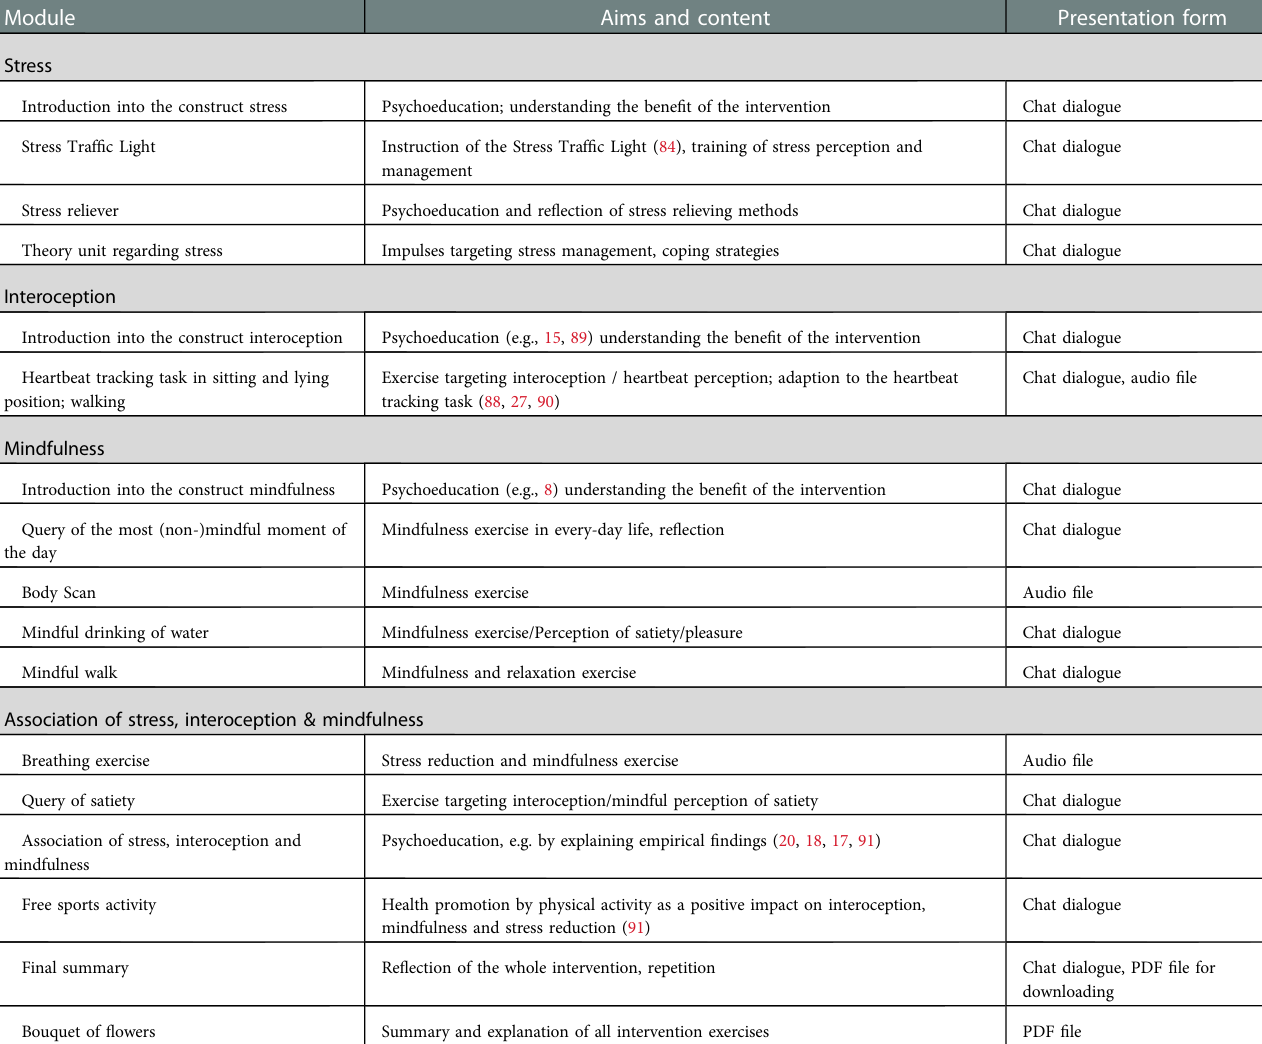
TABLE 1 Overview of the intervention contents.